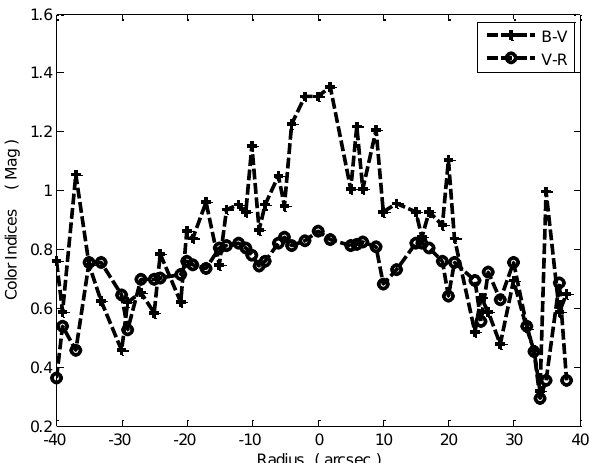
Fig.5: Profiles of the color indices along the major axis of the galaxy NGC